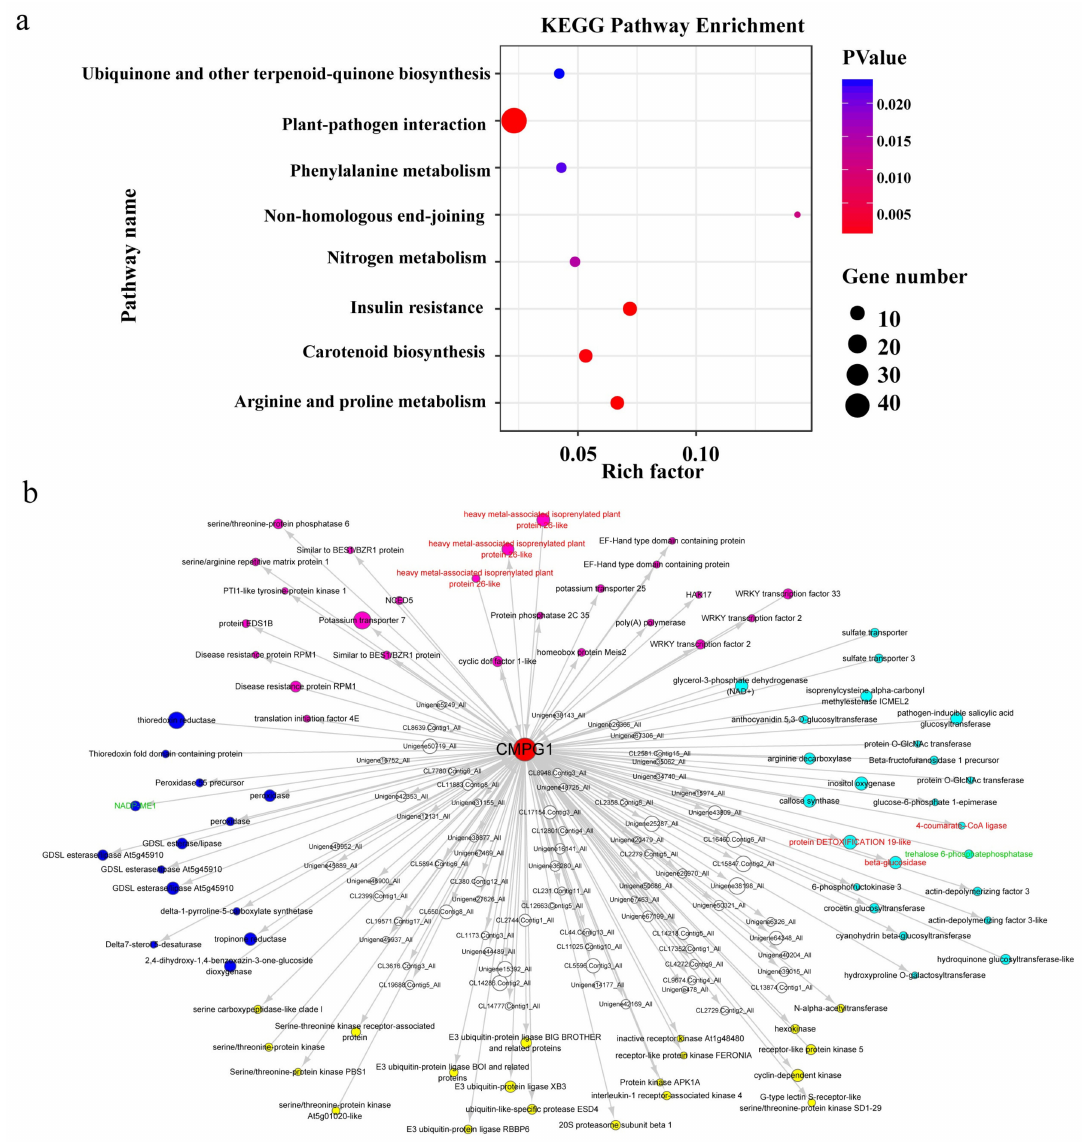
Figure 8. Coregulated genes expression network of CMPG1-V module. ( a ) KEGG enrichment analysis with all the genes in the pink module; ( b ) upstream and downstream network of CMPG1-V . Rose red nodes are related to signaling, light blue nodes are related to metabolism, blue nodes are related to oxidation–reduction, yellow nodes are related to protein modification. Red label font represents genes interacting with CMPG1-V obtained by yeast two-hybrid. Green label font represents genes having qRT-PCR results in previous study. Genes with the edge weight higher than 0.11 are visualized by